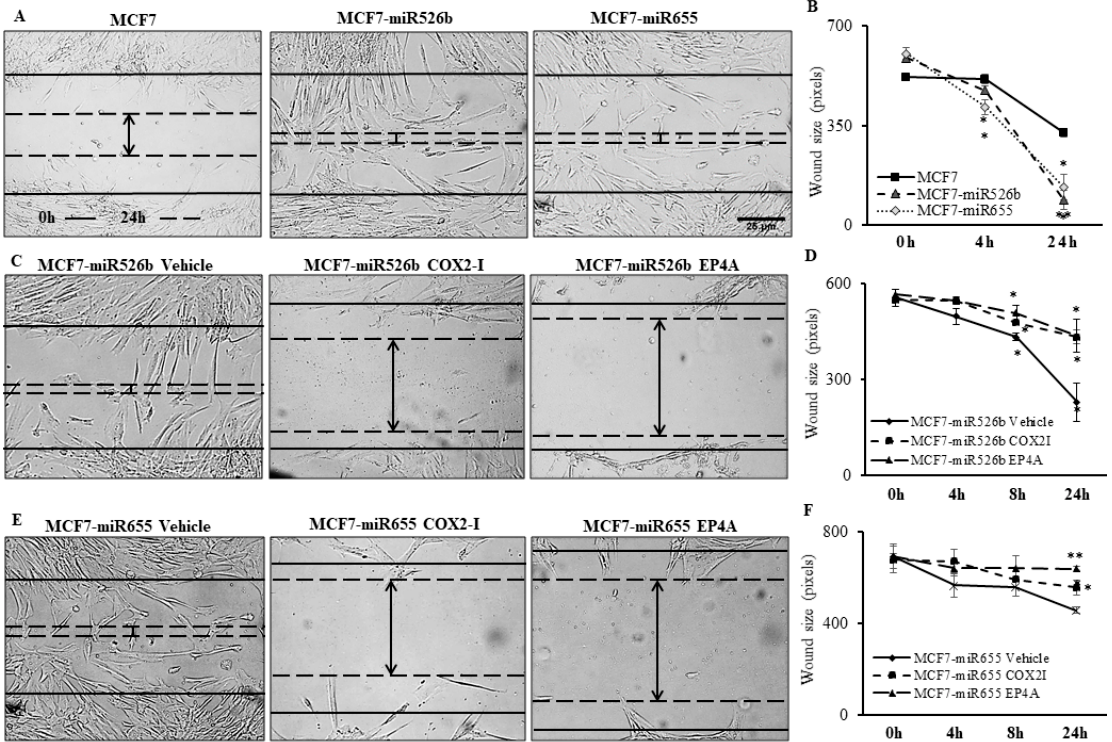
Figure 3. MCF7-miR526b and MCF7-miR655 conditioned media promotes cellular migration of HUVECs and inhibition of the COX2 / EP4 signaling pathway abrogates these phenotypes. Baseline scratches represented by black line; wound size at 24 h represented by dashed line. ( A ) Images of migration assay with conditioned media from MCF7, MCF7-miR526b, and MCF7-miR655 at the 24 h time point. ( B ) Quantitative data representing wound size per time point in conditioned media from MCF7, MCF7-miR526b, or MCF7-miR655. ( C ) Images of migration assay with conditioned media from MCF7-miR526b with the addition of vehicle, COX2-I, or EP4A, at the 24 h time point. ( D ) Quantitative data representing wound size per time point in conditioned media from MCF7-miR526b with the addition of either vehicle, COX2-I, or EP4 A. ( E ) Images of migration assay with conditioned media from MCF7-miR655 with the addition of vehicle, COX2-I, or EP4A , at the 24 h time point. ( F ) Quantitative data representing wound size per time point in conditioned media from MCF7-miR655 with the addition of either vehicle, COX2-I, or EP4A . Data shown as mean ± SEM of three biological